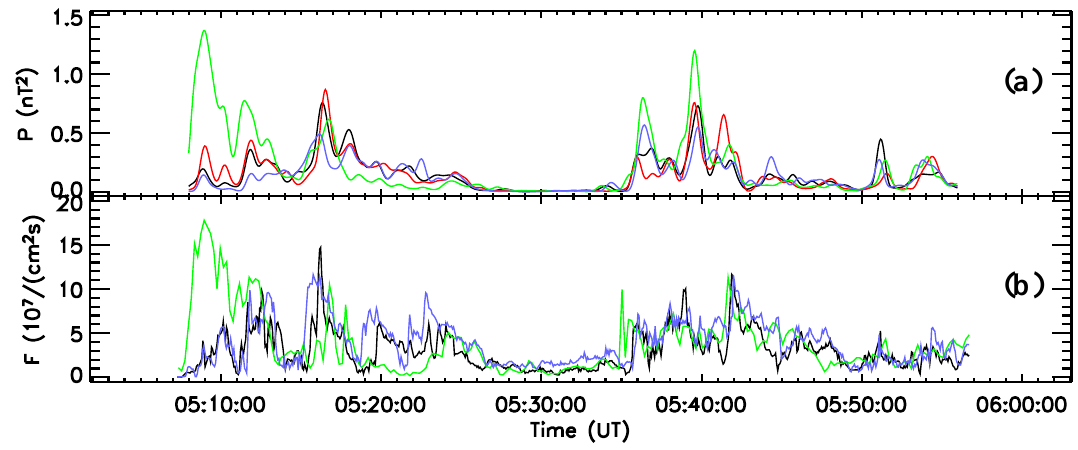
Fig. 5. Panel (a) shows the total integrated power in the magnetic field fluctuations observed by the FGM instruments on all four spacecraft between 05:00–06:00 UT. The frequency range is 0.06Hz–3Hz and a 2048 point window shifted with a 4-s increment is used). Panel (b) shows the total ion plasma number flux measured by sc1, sc3 and